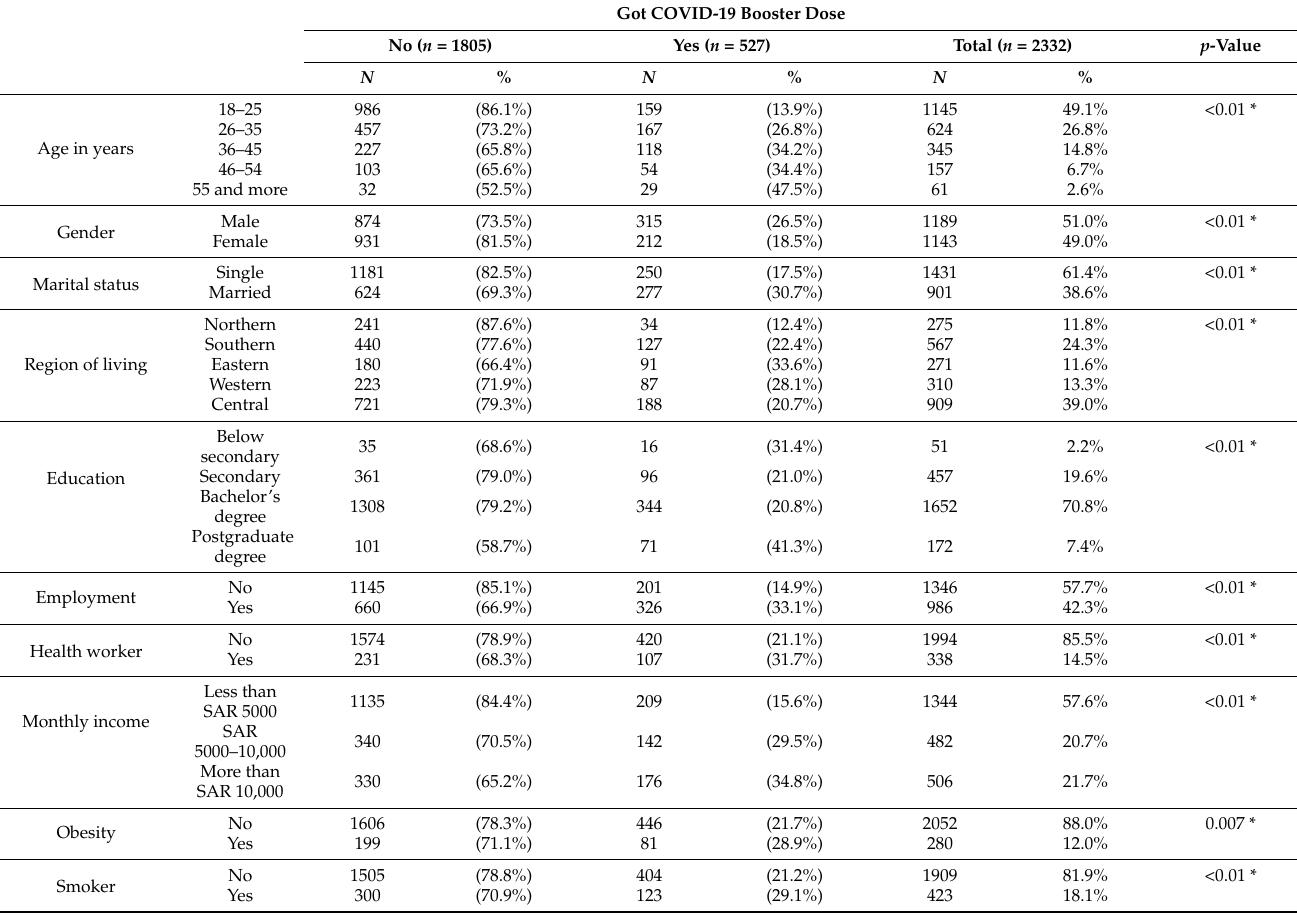
Table 1. Socio-demographic characteristics of the study’s